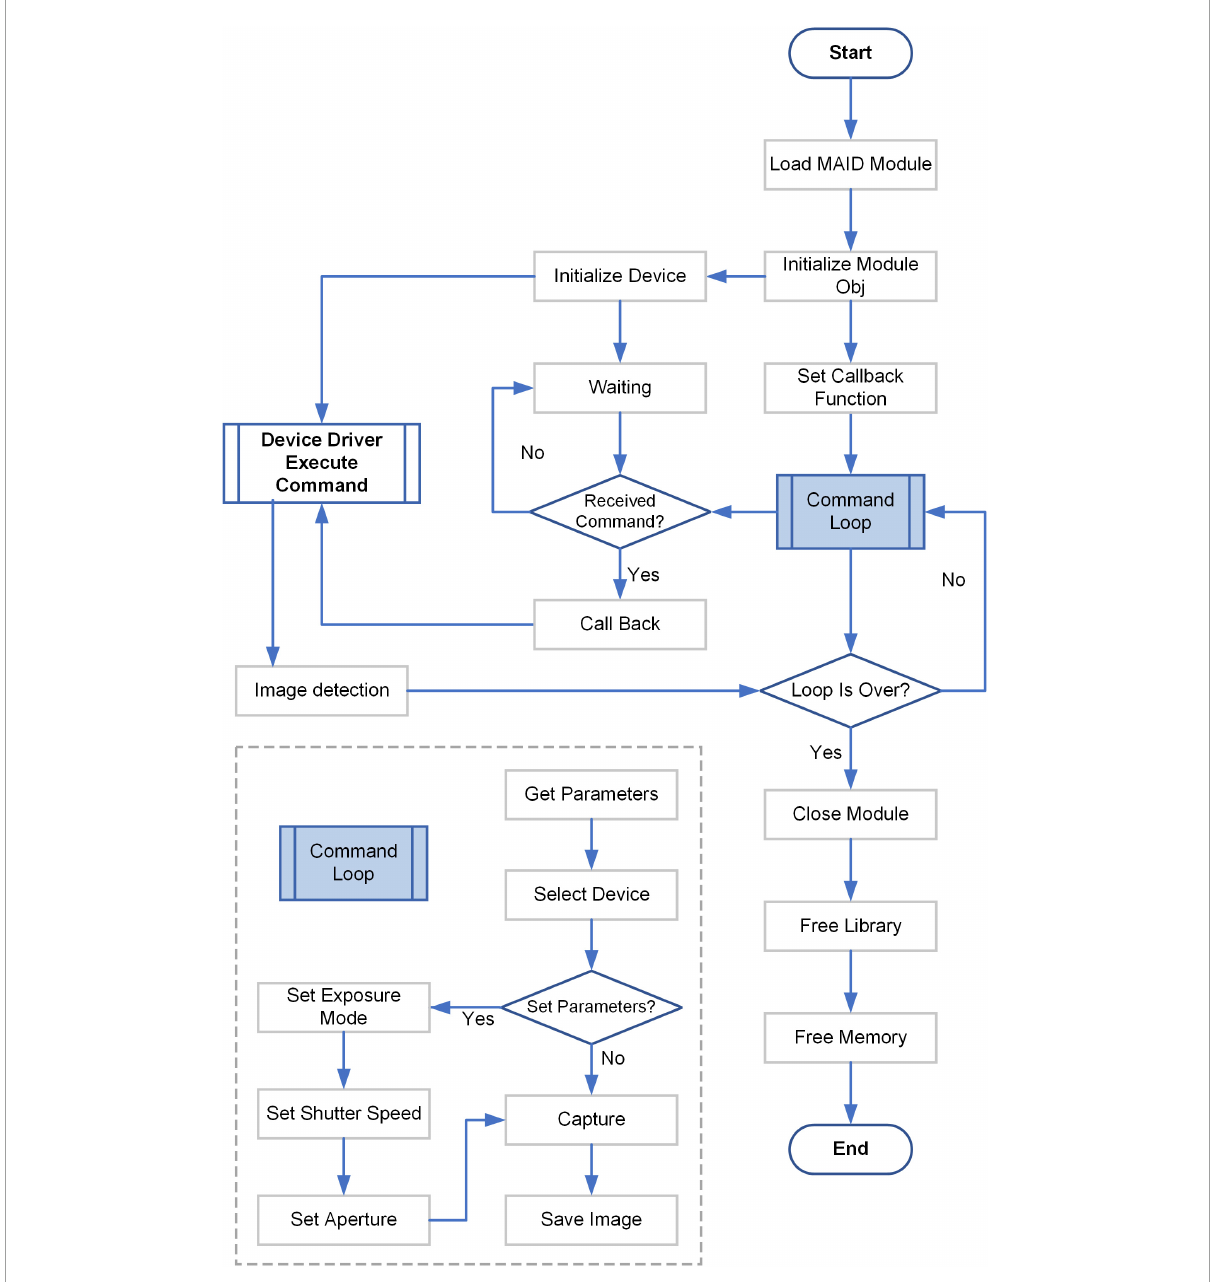
FIGURE3 Control diagram for the digital